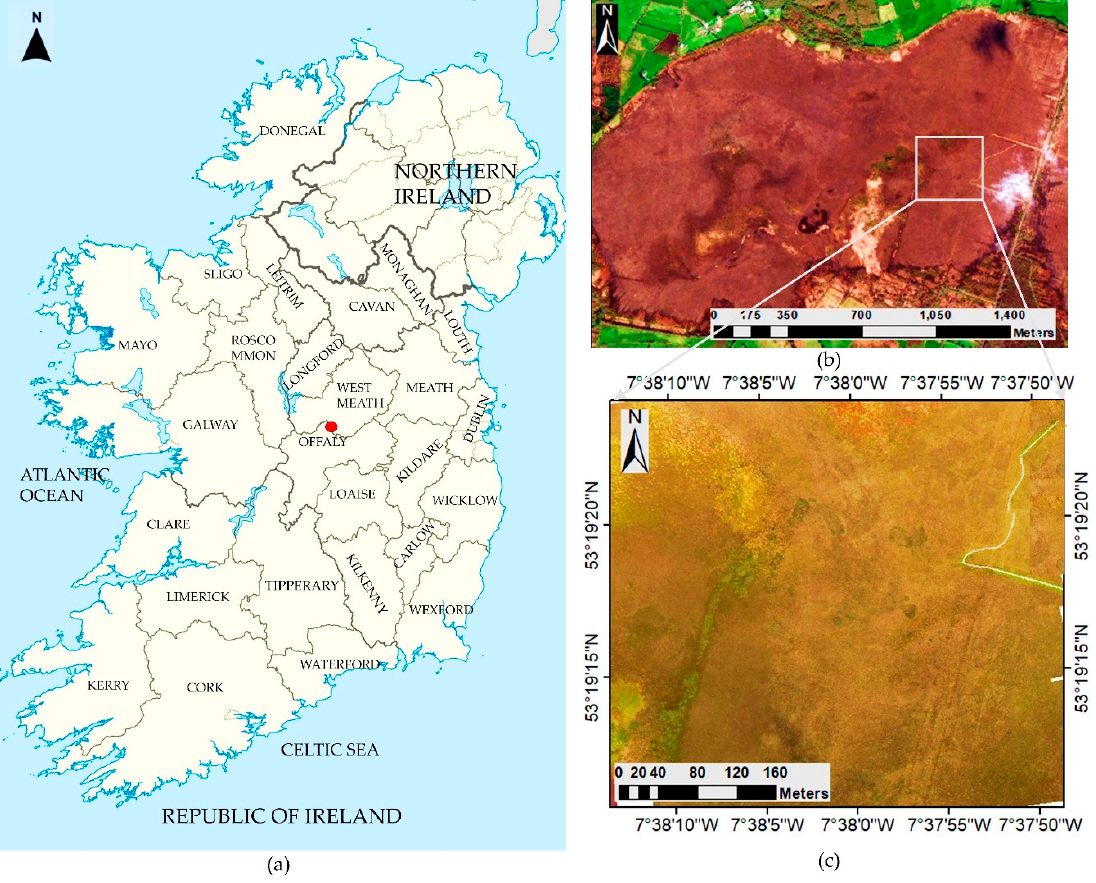
Figure 1. Study area: ( a ) map of Ireland (with the highlighted area: Clara Bog). ( b ) West of Clara Bog, County Offaly (with the highlighted area covered by drone). ( c ) Area covered by DJI Inspire 1 TM drone.